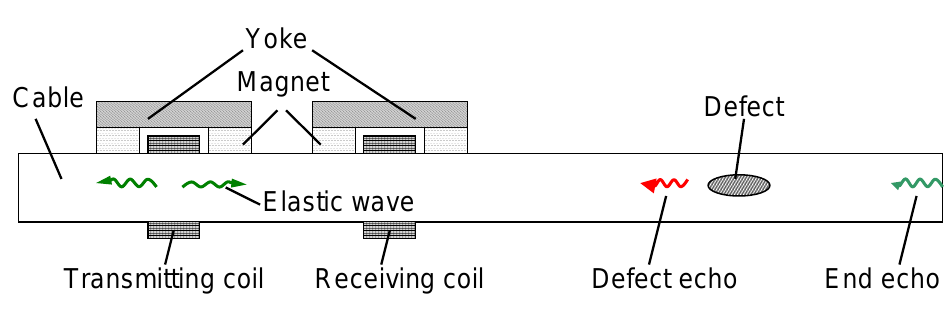
Figure 4. Principle of MGW